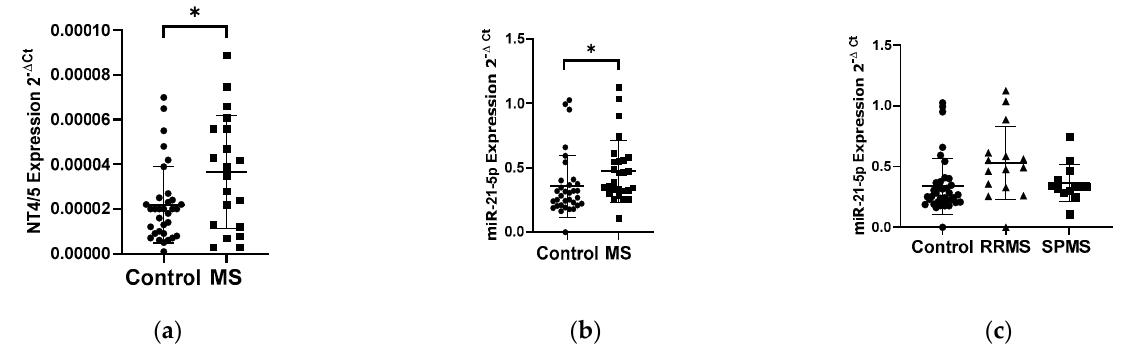
Figure 2. Expression levels of NT4/5 and miR-21-5p in PBMCs from multiple sclerosis patients and healthy controls. Expression levels (2 - ∆ Ct ) are shown for: ( a ) NT4/5 and ( b ) miR-21-5p, and ( c ) the expression level of miR-21-5p in PBMCs of MS patients according to type: RRMS ( n = 13), SPMS ( N = 15), and the control group ( N = 33). The PBMCs were from multiple sclerosis patients ( N = 28), aged 59 ± 5.5 years, and healthy controls, aged 60 ± 6 years ( N = 33). Expression levels were determined by real-time PCR (see Methods). Statistical analysis of differences between the groups of data was carried out using the Mann–Whitney U-test. Values of p ≤ 0.05 were regarded as statistically significant ( p * ≤ 0.05).